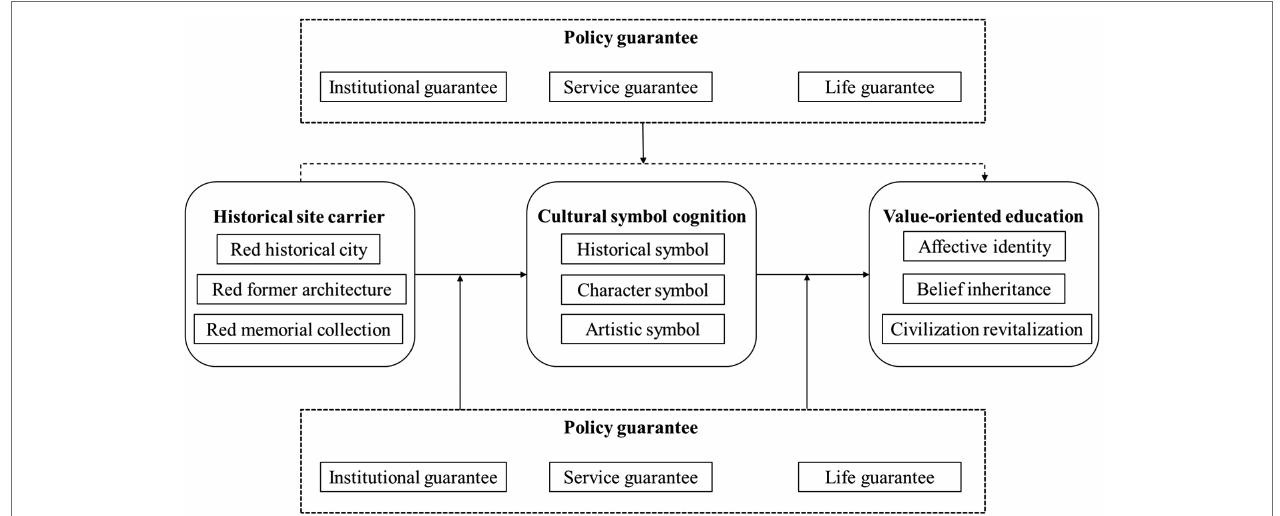
FIGURE 2 | Theoretical model of the political culture